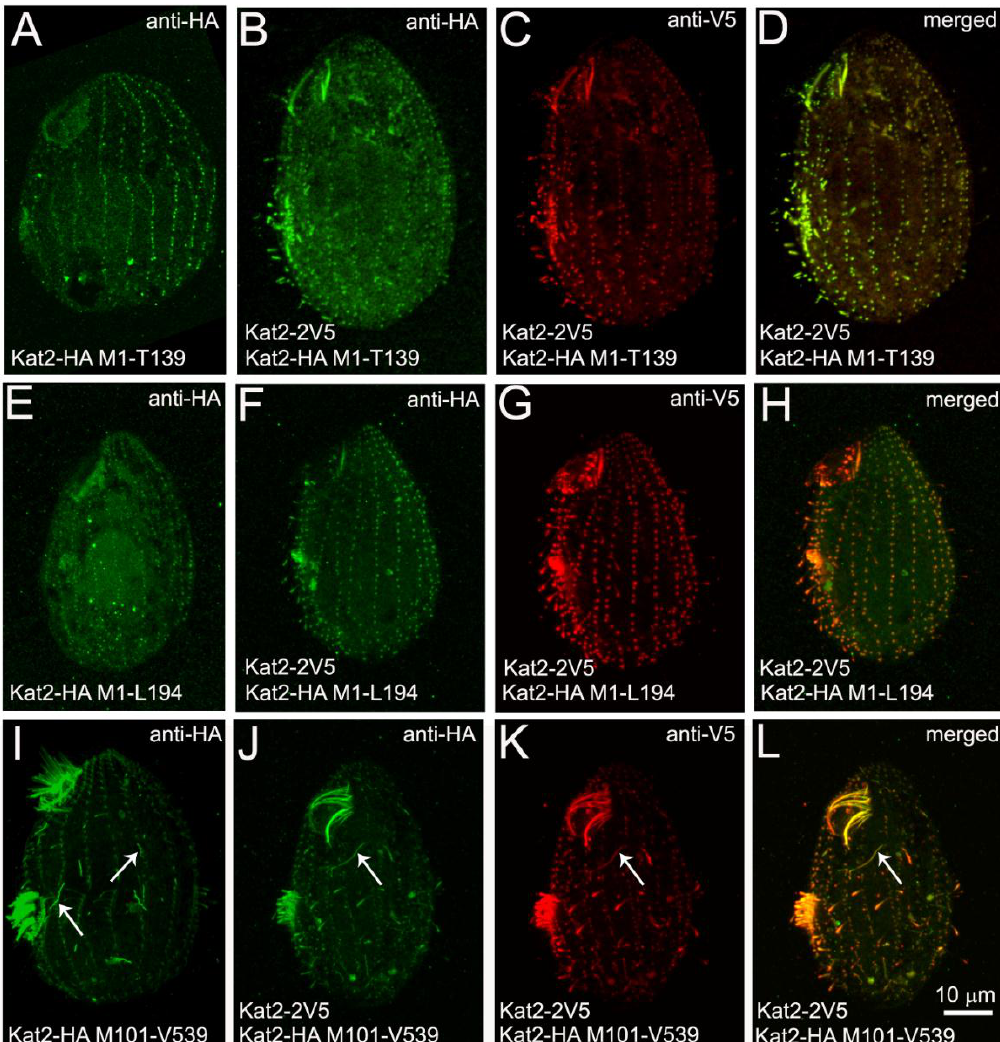
Figure 7. Co-overexpression of full-length Kat2-2V5 and HA-tagged Kat2 truncations causes the re-localization of proteins. Immunofluorescence confocal images of cells overexpressing either only C-terminally HA-tagged Kat2 truncations: ( A ) Kat2-HA M1-T139, ( E ) Kat2-HA M1-L194, or ( I ) Kat2-HA M101-V539, or co-overexpressing full-length Kat2-2V5 and HA-tagged Kat2 truncations: Kat2-HA M1-T139 ( B – D ), Kat2-HA M1-L194 ( F – H ), or Kat2-HA M101-V539 ( J – L ). Cells were stained with anti-HA ( A , B , E , F , I , J ) and anti-V5 ( C , G , K ) antibodies. ( D , H , L ) Merged images. Note that the pattern of co-overexpressed proteins overlaps ( D , H , L ). White arrows point to the fibers specifically present in cells overexpressing Kat2 M101-V539. Bar = 10 μm.